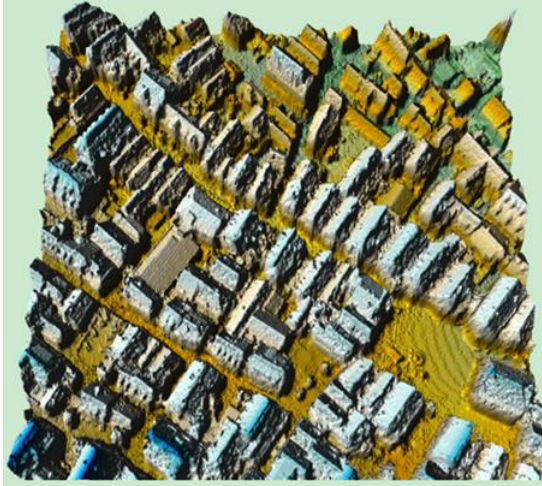
Fig.9 The Pleiades-1 image in Hong